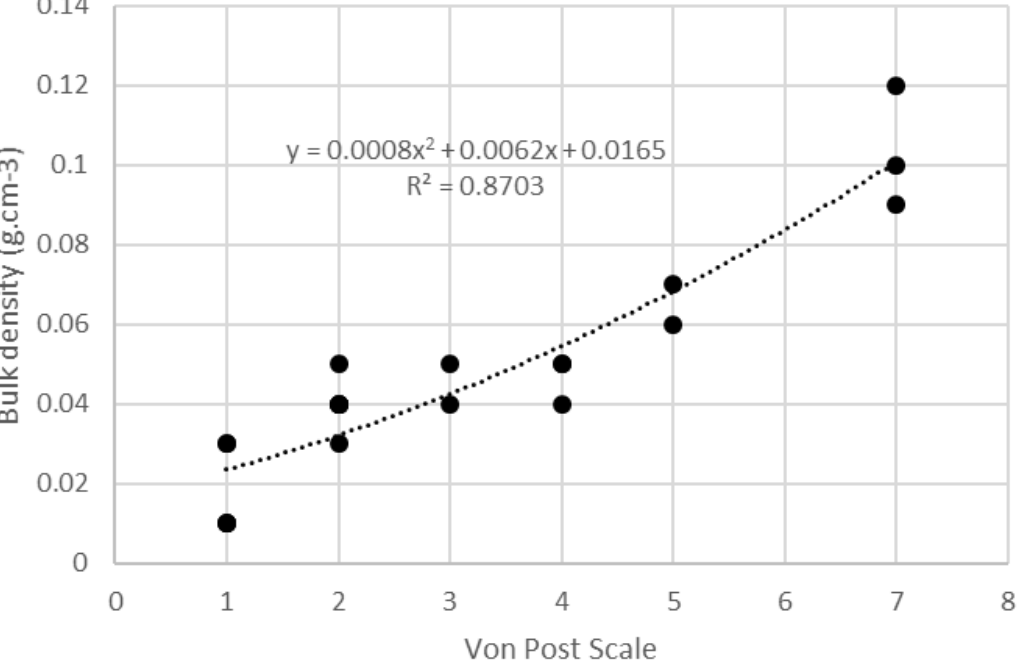
Figure 5. Relationship between BD and von Post huification of the layers